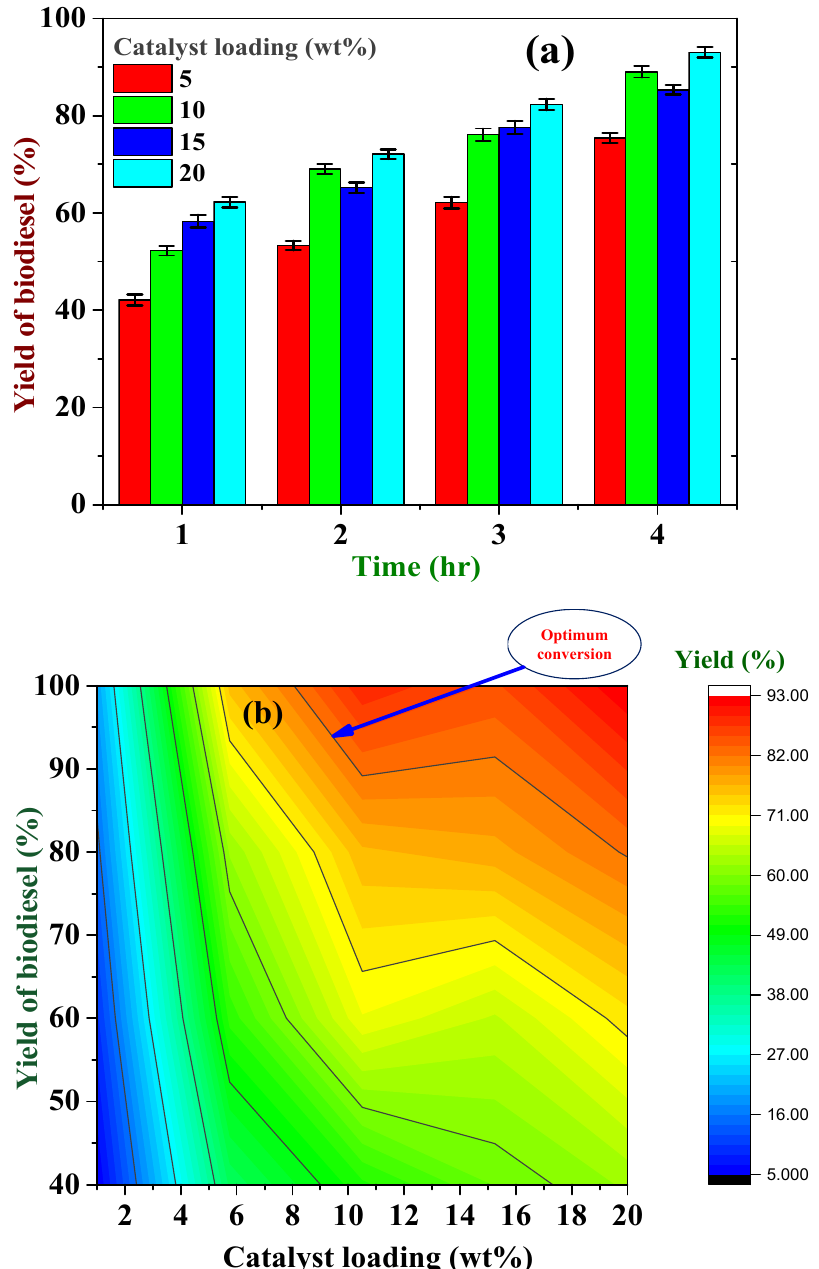
Figure 3. ( a ) Effect of catalyst loading on yield of biodiesel at optimum temperature of 60 °C for varying reaction time; ( b ) The optimum yield region isopleth diagram.